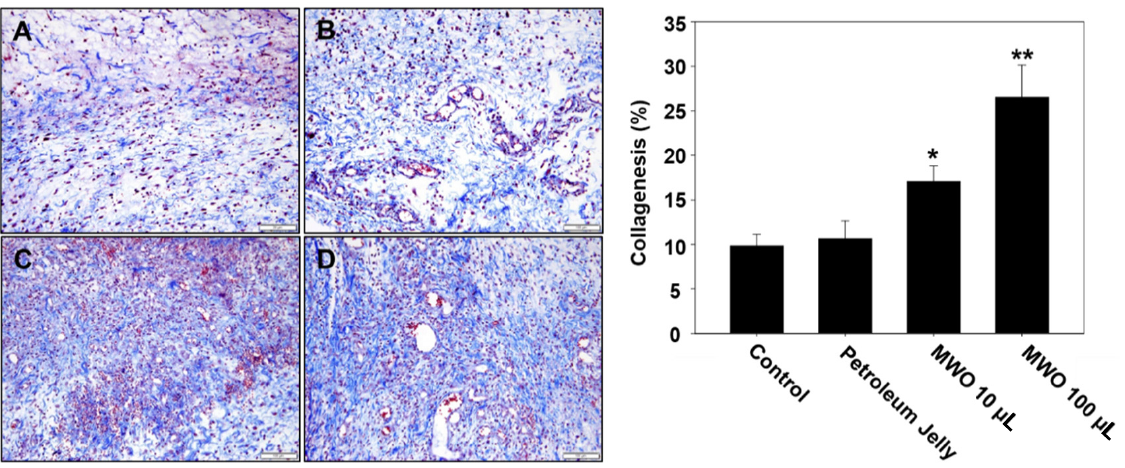
Figure 5. Effect of MWO on the collagen deposition in skin wounds of rats. The tissues harvested from the skin wound area of rats treated with or without MWO were used in Masson’s trichrome staining for collagenesis. Masson’s trichrome staining between skin matrix is represented by the blue color (magnification ×200). The values are shown as means ± SD. * p < 0.05 and ** p < 0.01 compared to the control. ( A ) The skin wound area untreated with MWO. ( B ) Treated with petroleum jelly as a negative control. ( C ) Treated with 10 μ L MWO. ( D ) Treated with 100 μ L MWO.